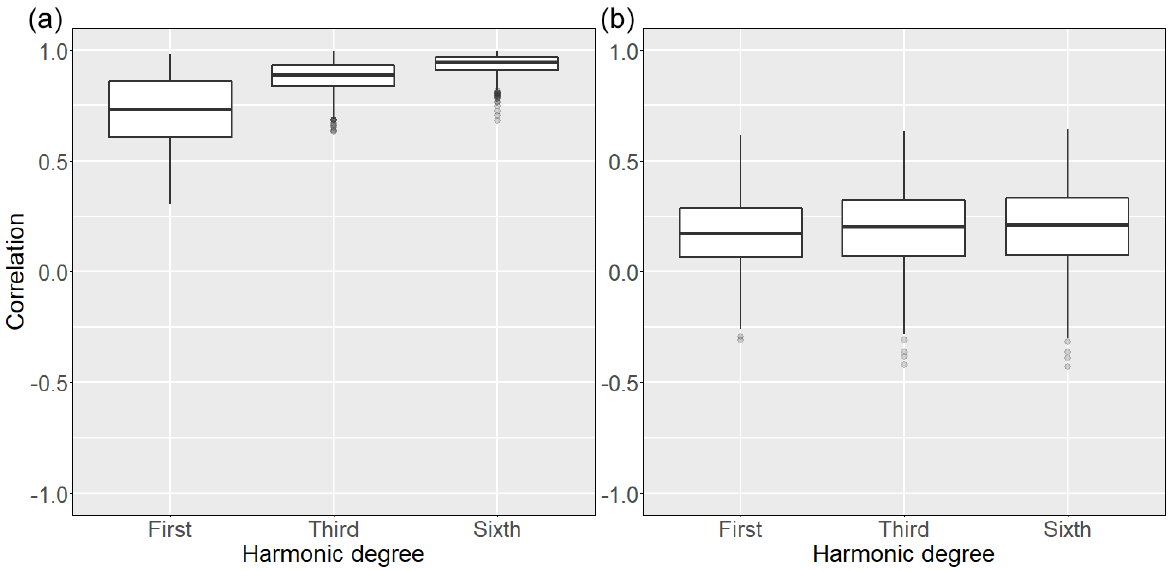
Figure 3. ∆ Harmonics calculation based on detrended monthly median MODIS NDVI data of the Steigerwald between 2010 and 2019. ( a ) Fitted curve using a 1st harmonic degree. ( b ) Fitted curve using a 3rd harmonic degree. ( c ) Fitted curve using a 6th harmonic degree. ( d ) Difference ( ∆ Harmonics) between NDVI values and the 6th degree harmonic fitted curve for months May–October.